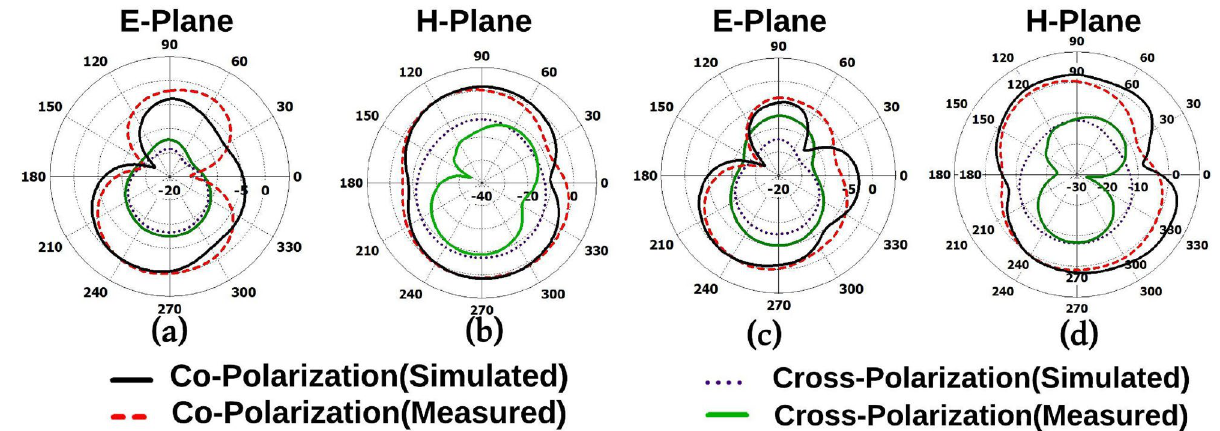
Figure 17. Radiation pattern (simulated and measured) for UWB radiators.